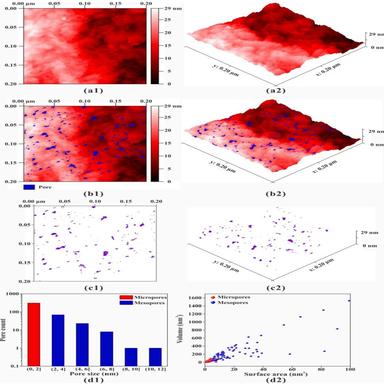
Pore segmented results of sample M1-3 at 0.2 μm scan size by the watershed method: (a1), (a2) are original matrix surface; (b1), (b2) are 2D, 3D spatial distribution of pore recognized by watershed method; (c1), (c2) are 2D, 3D spatial distribution of pore extracted from the matrix; (d1) is pore size distribution; (d2) is correlation between the surface area and volume of each pore.